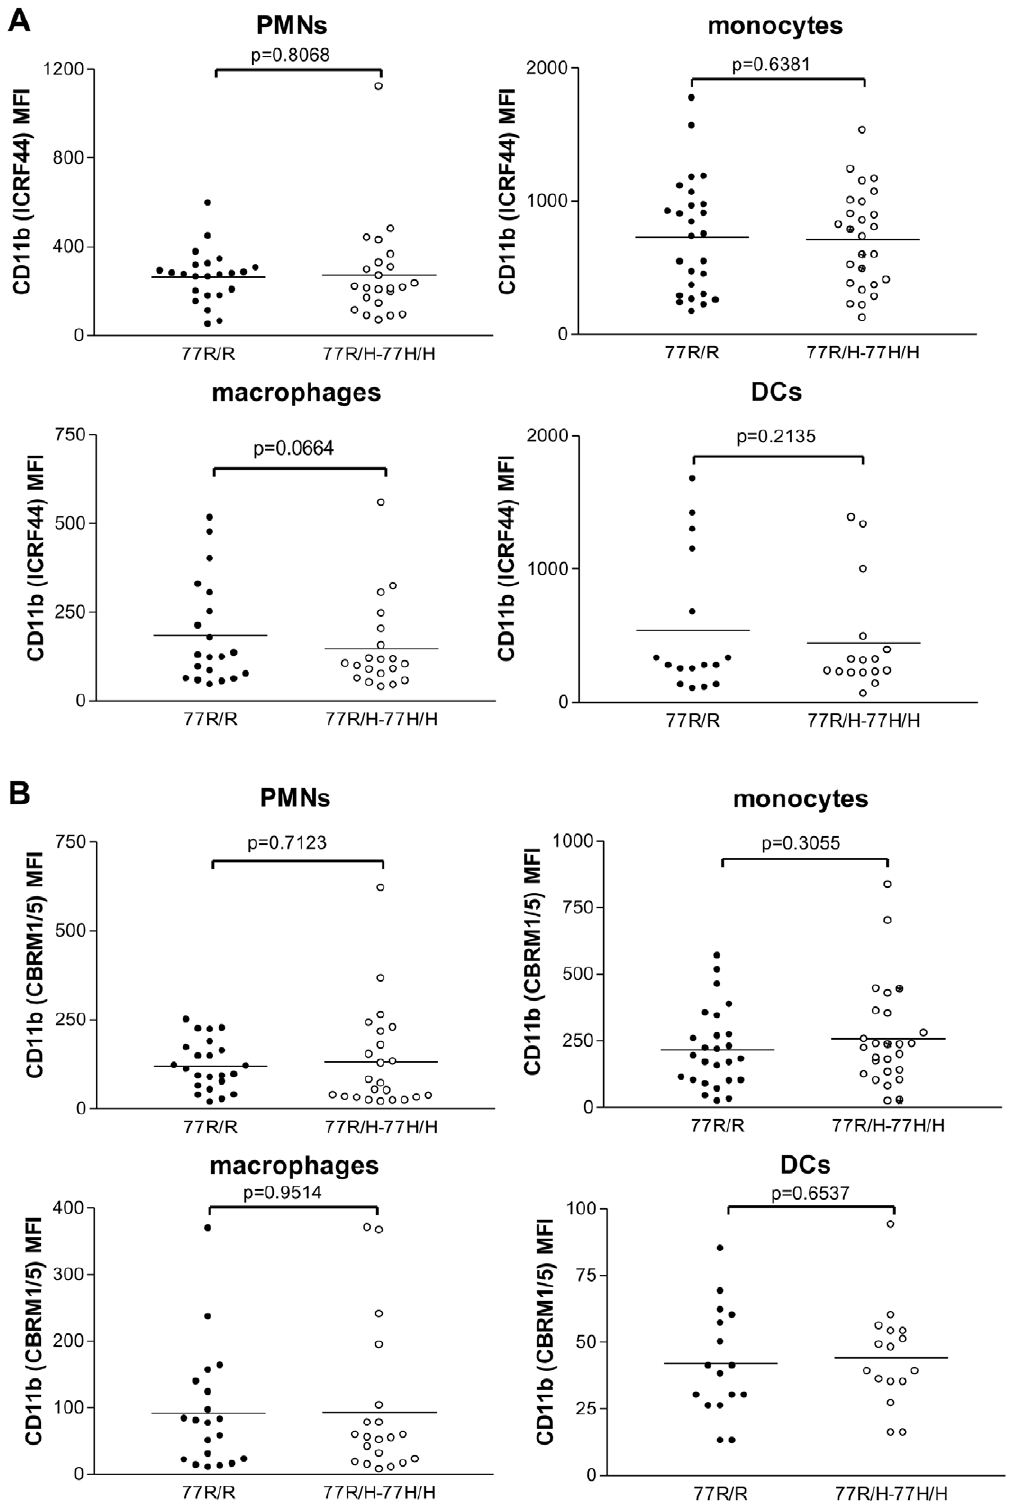
Figure 1. Cell surface expression of CD11b on different cell populations. The expression was quantified by flow cytometry using ICRF44 (A) and CBRM1/5 (B) antibodies. The latter only recognises the headpiece of CD11b in its active state. Data are presented in mean fluorescence intensity (MFI), closed symbols 77R/R donors, open symbols 77R/H-77H/H donors. The two groups were not statistically different. Bars indicate means.